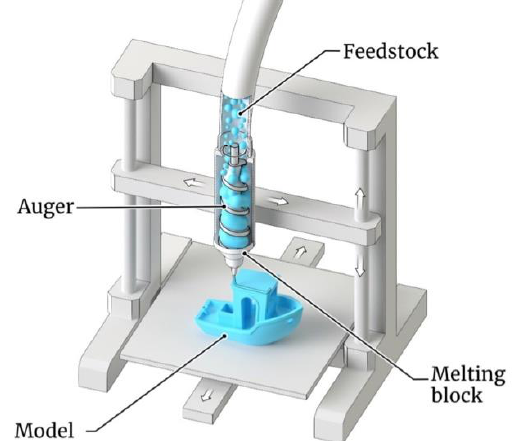
Figure 1. Schematic layout of the laboratory unit for additive manufacturing of samples by extru- sion.